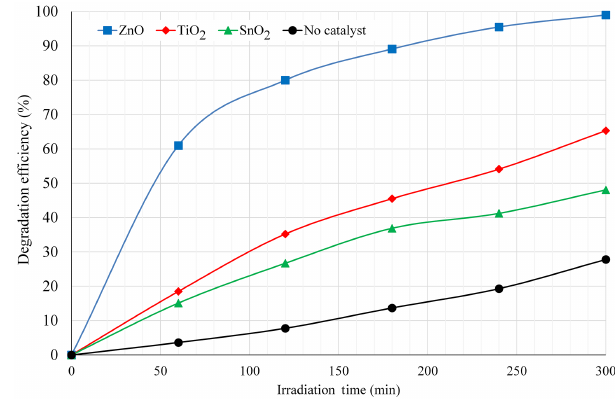
Figure 7. Degradation efficiency of BPA in aqueous suspensions of ZnO, TiO 2 and SnO 2 under UV irradiation.